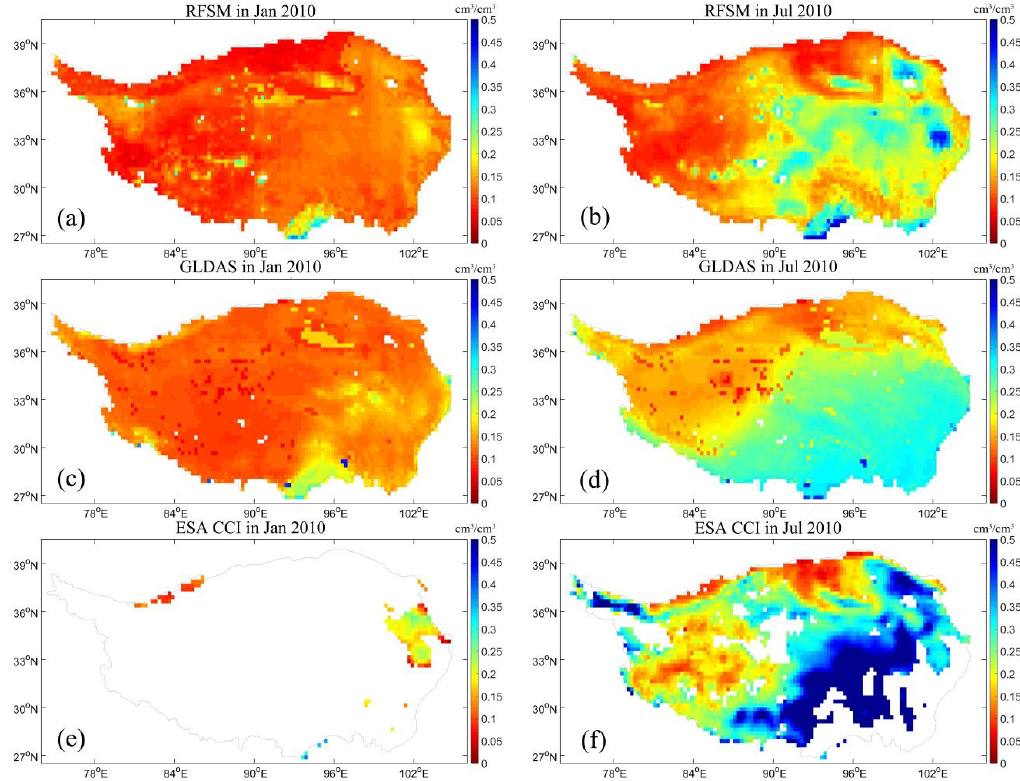
Figure 11. Spatial distribution of RFSM, GLDAS and ESA CCI SM in 2010: ( a ) RFSM in Jan; ( b ) RFSM in Jul; ( c ) GLDAS in Jan; ( d ) GLDAS in Jul; ( e ) ESA CCI in Jan; ( f ) ESA CCI in Jul.